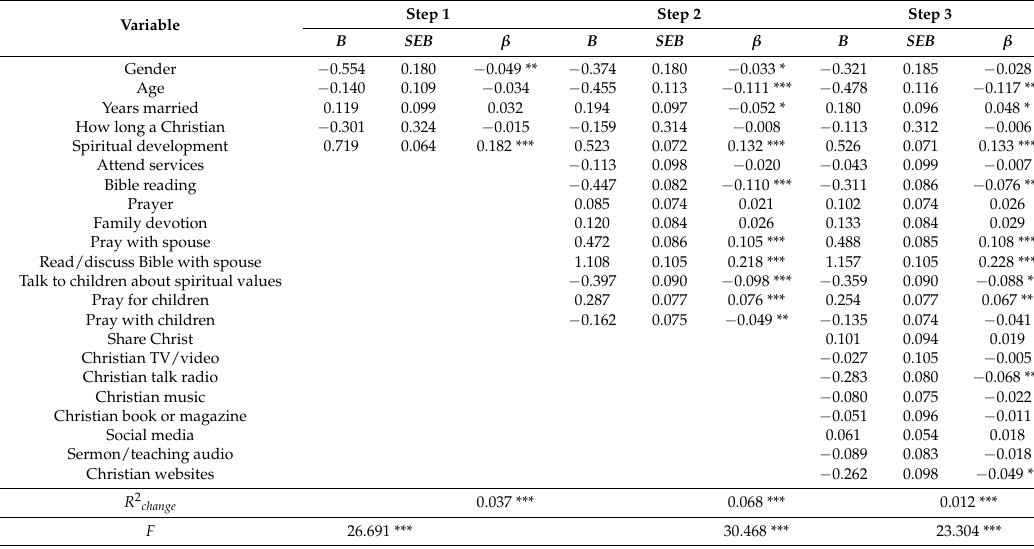
Table 3. A summary of the hierarchical regression analysis for variables predicting a positive marital quality ( N = 6613).